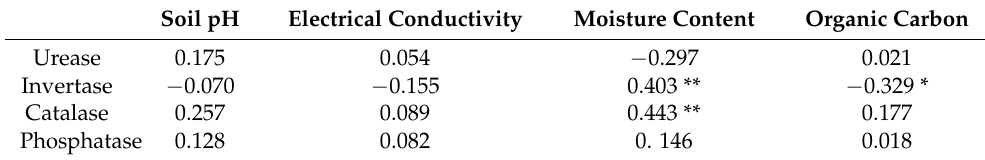
Table 3. Correlation results between enzyme activity and physicochemical properties. Soil pH Electrical Conductivity Moisture Content Organic Carbon Urease 0.175 0.054 − 0.297